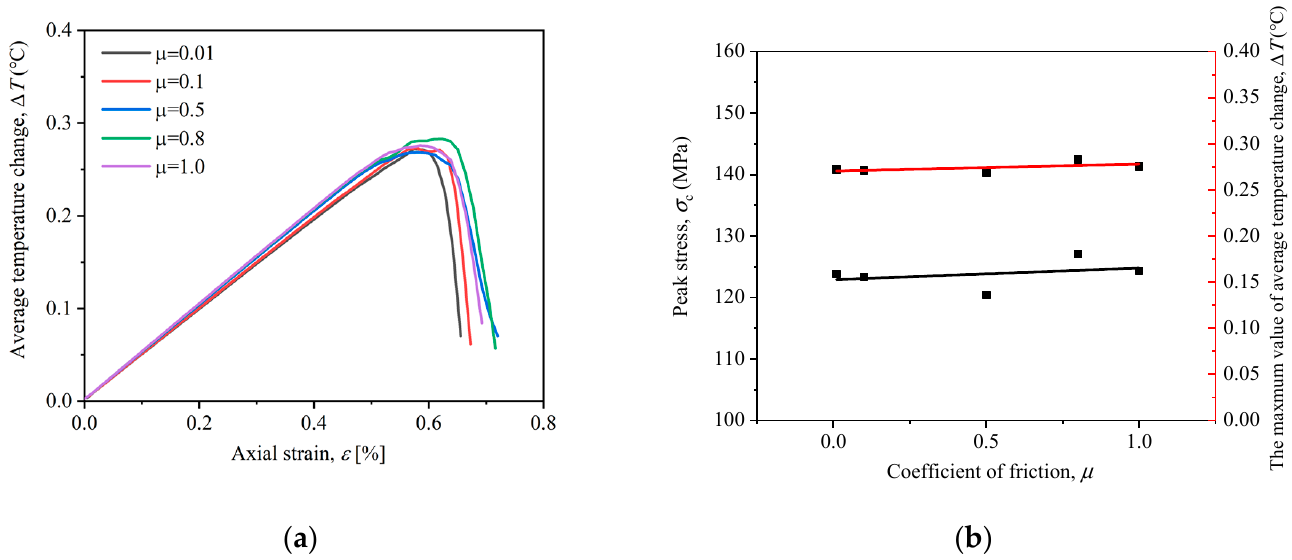
Figure 11. Effect of different friction coefficients on average temperature change ( a ); peak stress and the maximum value of average temperature change ( b ).